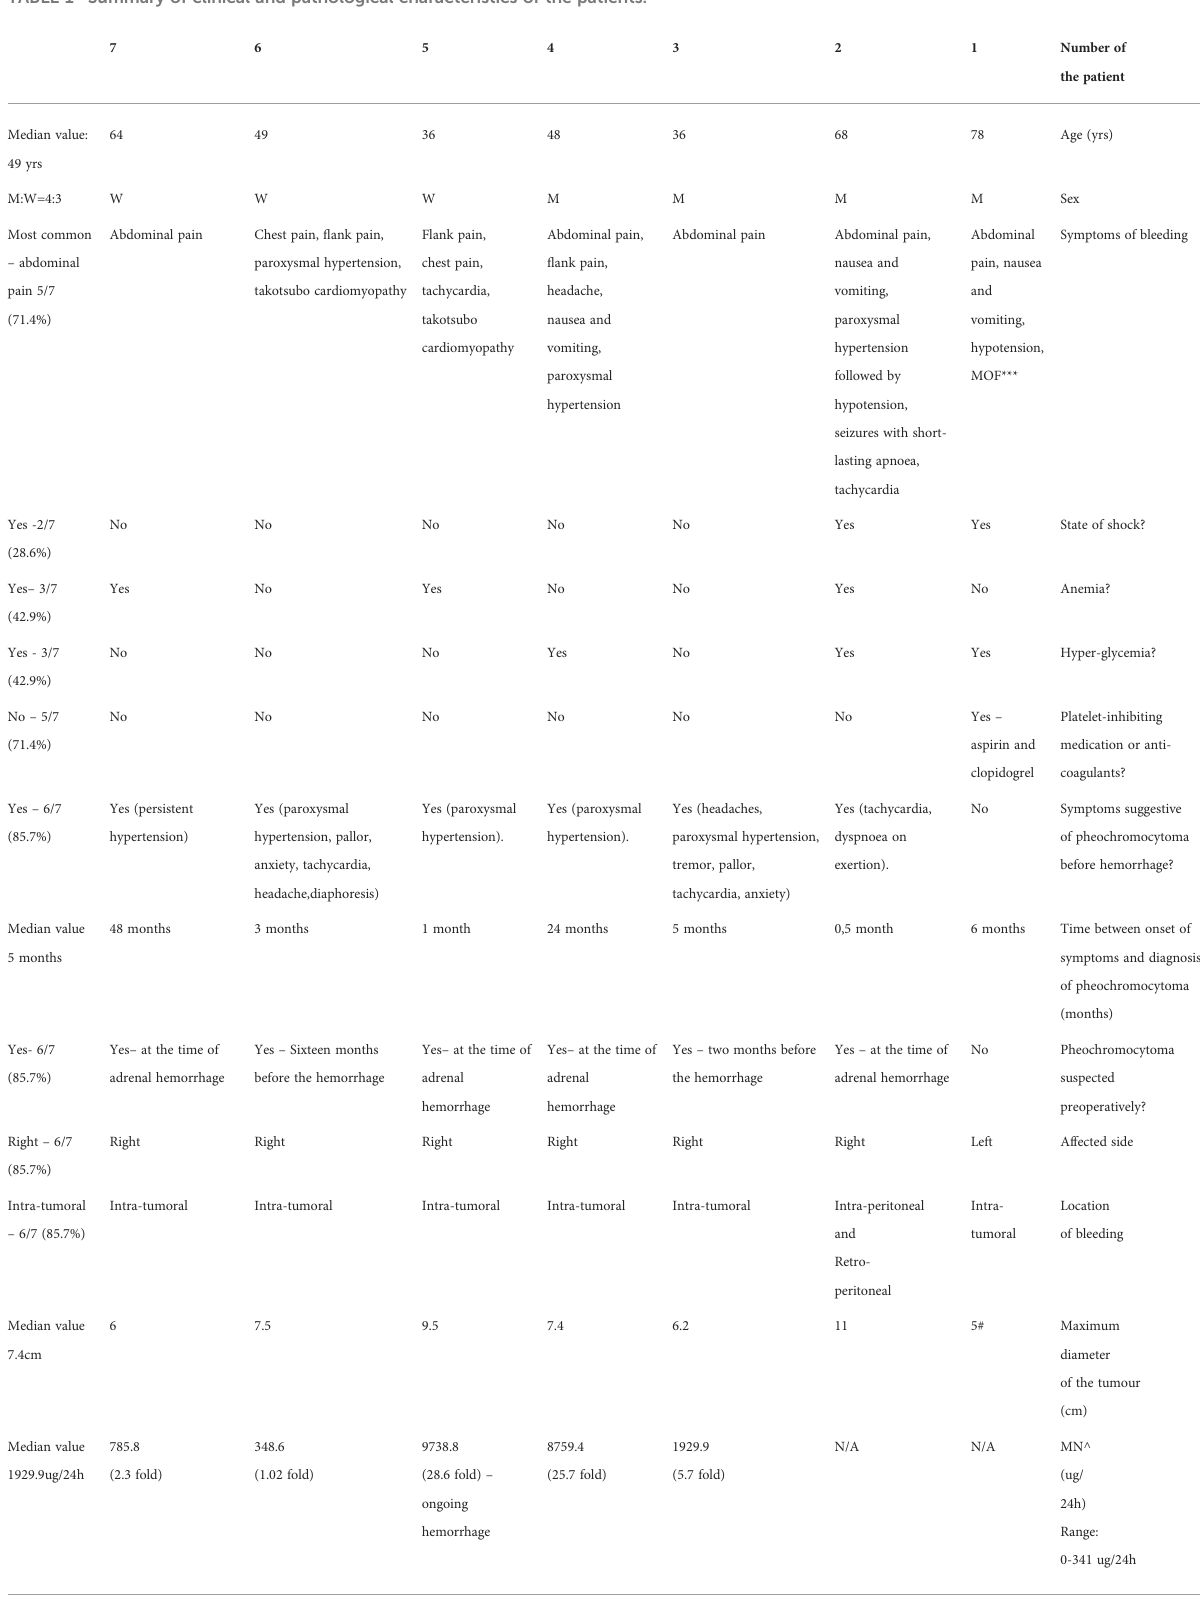
TABLE 1 Summary of clinical and pathological characteristics of the